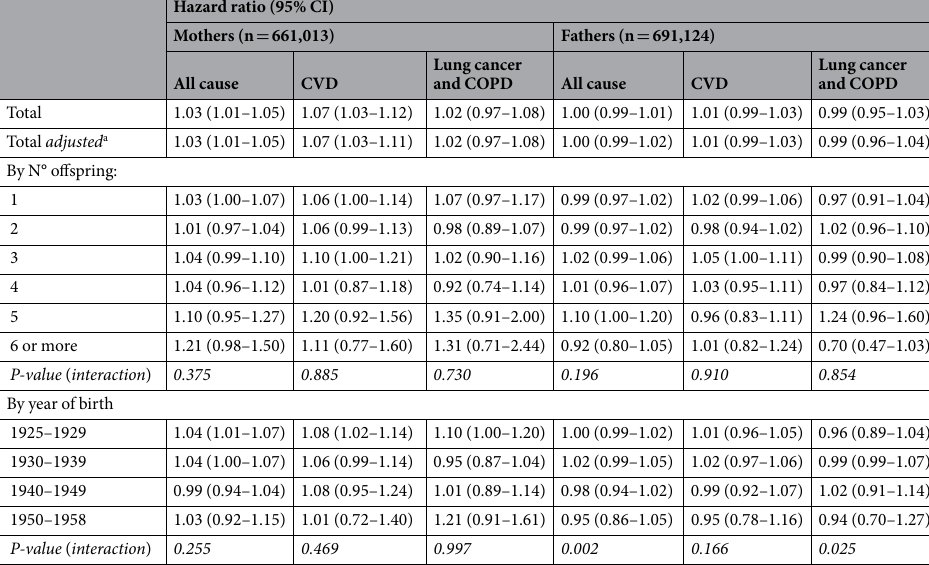
1.21 (0.98–1.50) 1.11 (0.77–1.60) 1.31 (0.71–2.44) 0.92 (0.80–1.05) 1.01 (0.82–1.24) 0.70 (0.47–1.03) P-value ( interaction ) 0.375